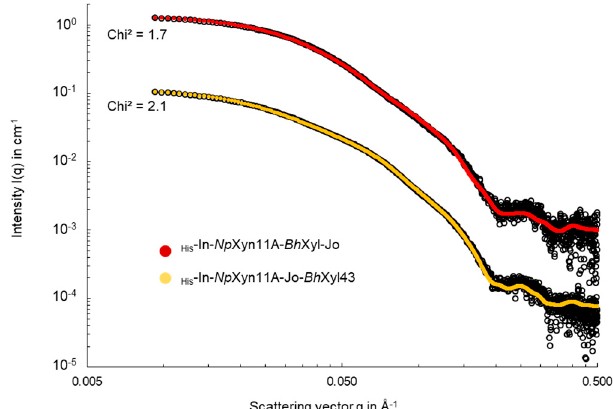
Figure 3. Superimposition of SAXS data from His -In- Np Xyn11A- Bh Xyl43-Jo and His -In- Np Xyn11A-Jo- Bh Xyl43 constructs and their structural models calculated with SASREFMX (red and orange line respectively). The data are presented as a plot of Log I(q) in cm − 1 vs. Log q in Å − 1 to magnify the region of small angles.